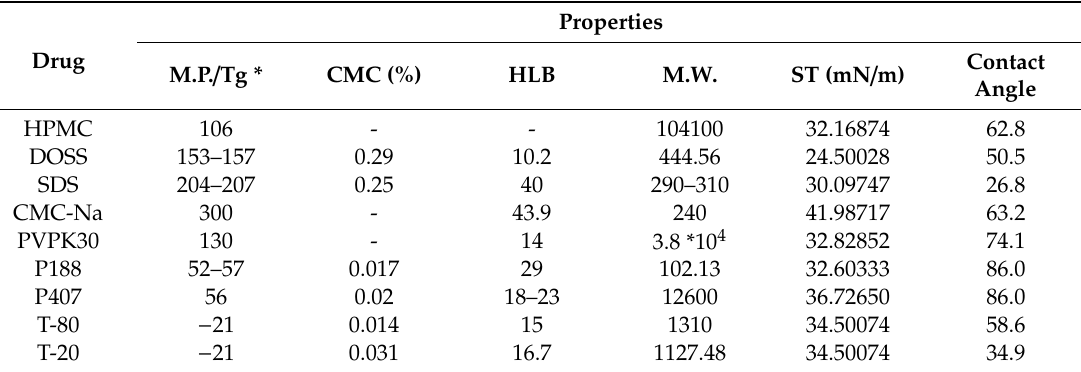
Table 2 and we designed the experiment according to Table 3. Table 2. List of the stabilizers and their properties.